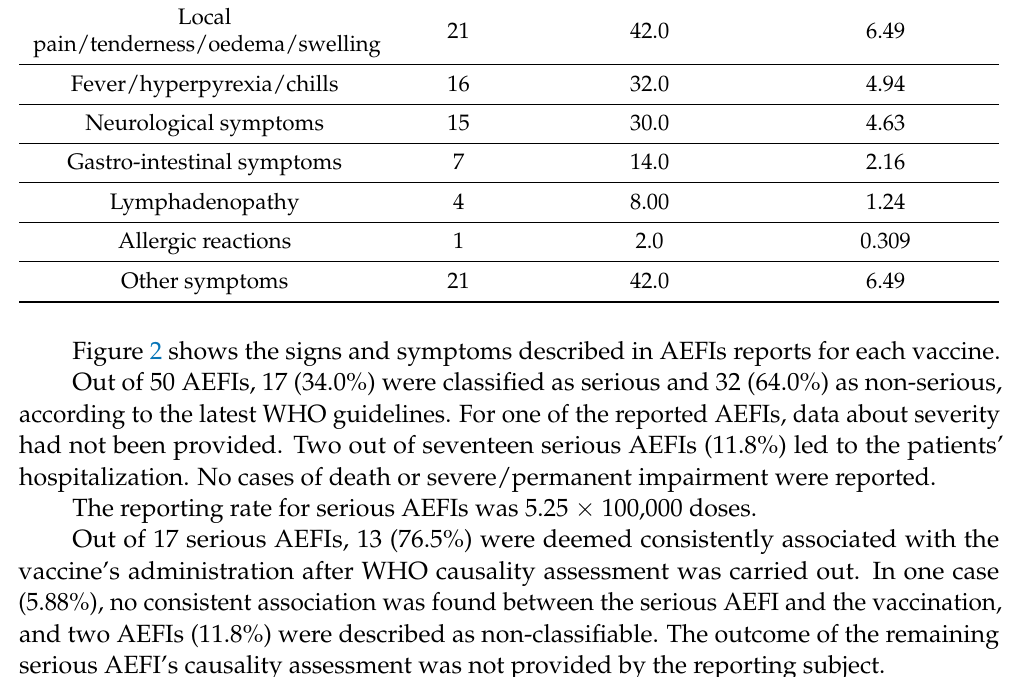
Table 3. Distribution of signs and symptoms described in AEFIs reports and the reporting rate × 100,000 administered doses.